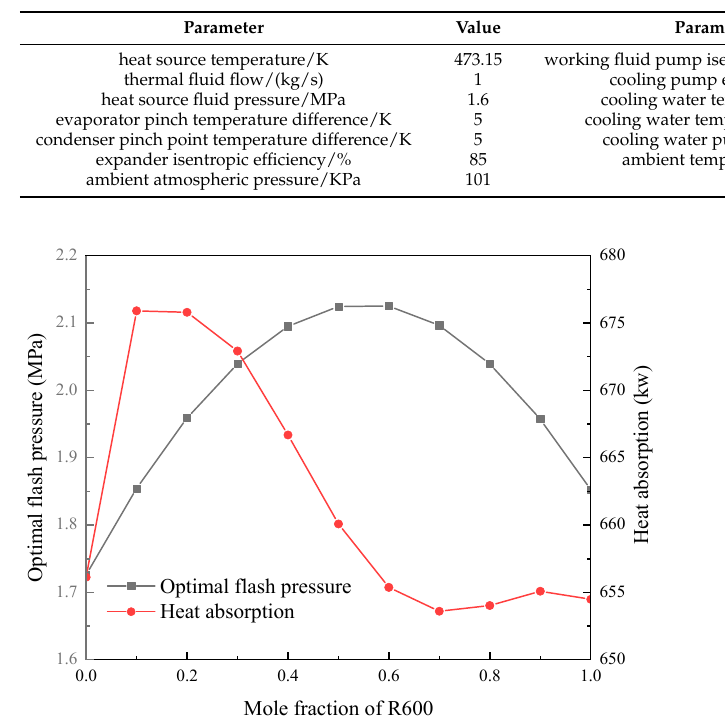
Table 4. Boundary conditions of the system.